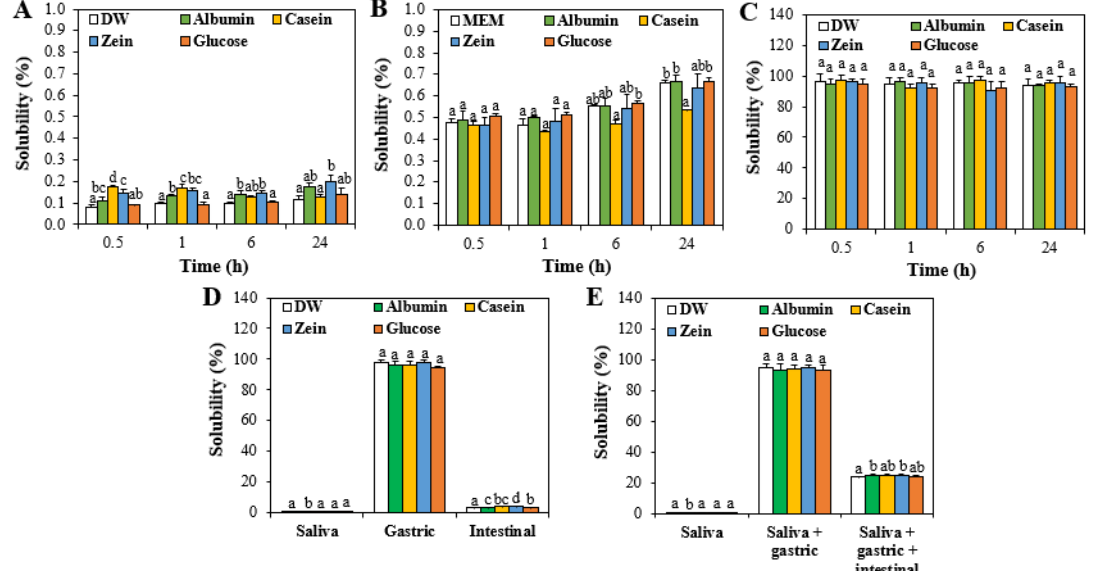
Figure 2. In vitro solubilities of ZnO NPs (5 mg/mL) interacted with food proteins or glucose in ( A ) distilled water (DW), ( B ) cell culture minimum essential medium (MEM), ( C ) artificial lysosomal fluid (ALF), ( D ) simulated digestion fluids, and ( E ) in vitro three consecutive digestion fluids at 37 °C. Different lowercase letters (a,b,c,d) indicate significant differences among different matrices ( p < 0.05).